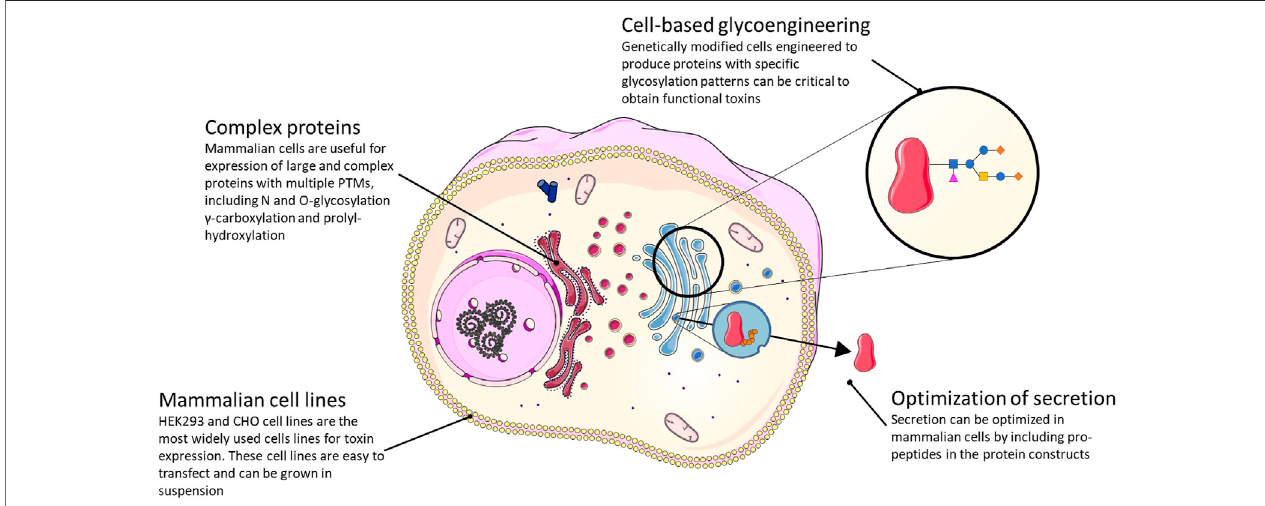
FIGURE 6 | Summary of the strategies available and their main advantages for the expression of functional toxins in a mammalian cell expression system.